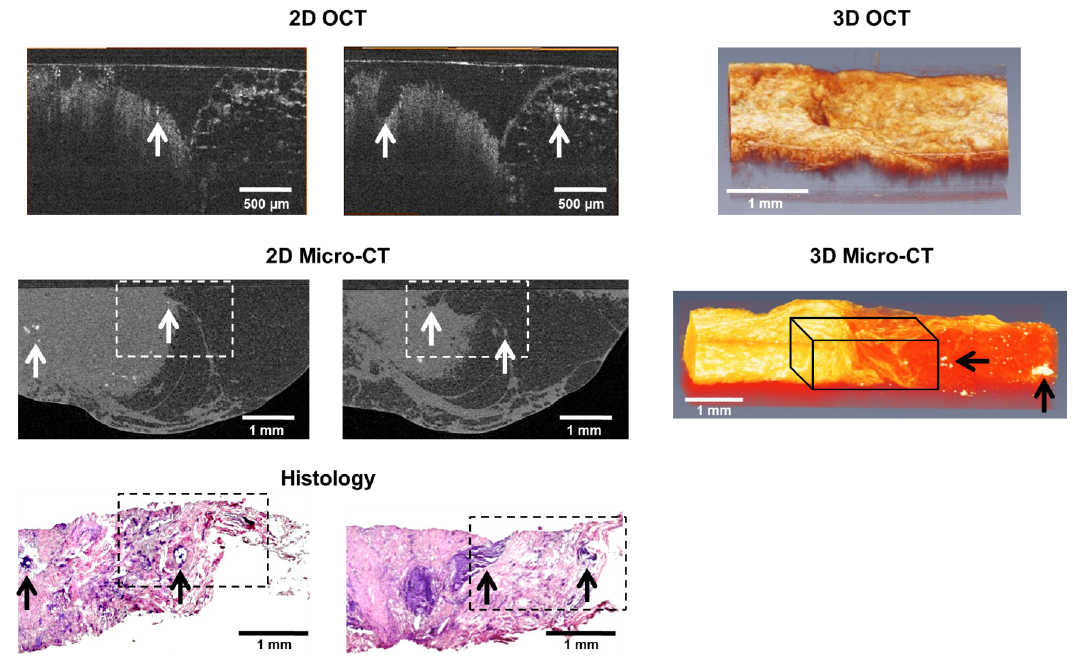
Fig. 1. Representative comparison of OCT, micro-CT and histology image data. The dotted white boxes in the micro-CT images and the dotted black boxes in the histology images (H&E) are the approximate scan areas of the corresponding OCT images. Tumor structures can be seen in all three modalities on the left-half of the images, with normal adipose tissue on the right-half. The arrows indicate corresponding structures and areas of microcalci¯cations. 3D OCT and micro-CT datasets are also shown. The black 3D wire-frame in the micro-CT image is the approximate scan area for the corresponding 3D OCT image. Microcalci¯cations (black arrows) appear bright in the micro-CT data of the adipose tissue on the right. The micro-CT volume is visualized using a direct volume rendering algorithm while the OCT volume is visualized using a surface mesh